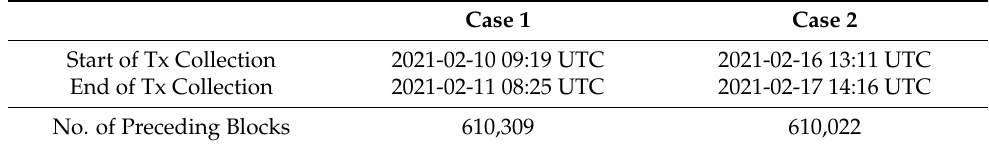
Table 5. Overview of Experimental Cases Run.